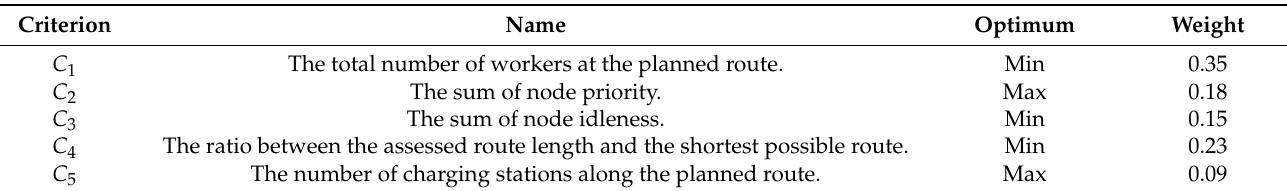
Table 1. The proposed route assessment